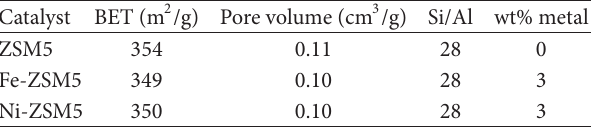
T 1: Textural properties of prepared